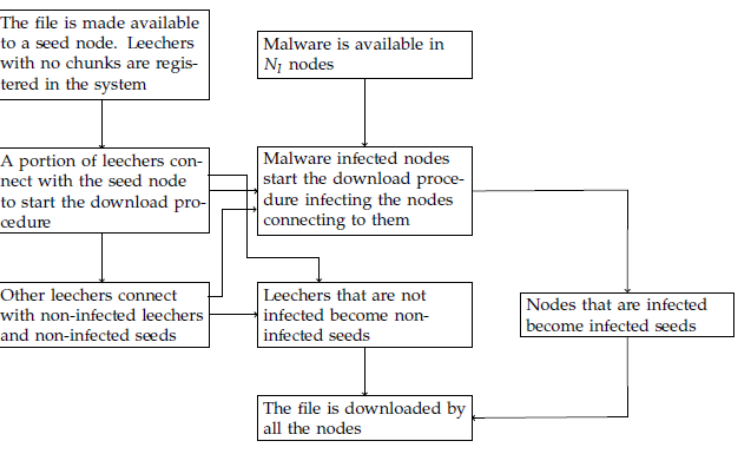
Figure 2. Flow chart for the operation of the malware attack in the P2P